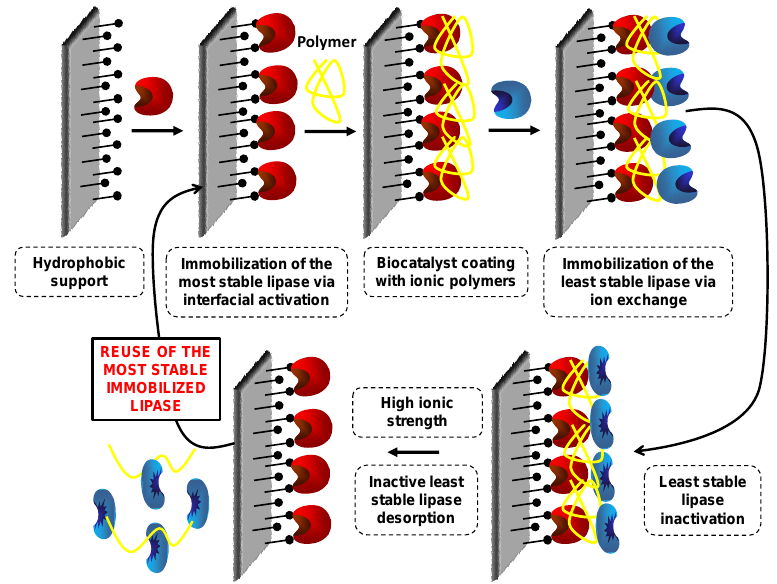
Figure 26. A strategy to coimmobilize two enzymes that permit the reuse of the most stable one combining immobilization via interfacial activation of the most stable enzyme, immobilized enzyme coating with ionic polymers and ion exchange immobilization of the least stable enzyme.